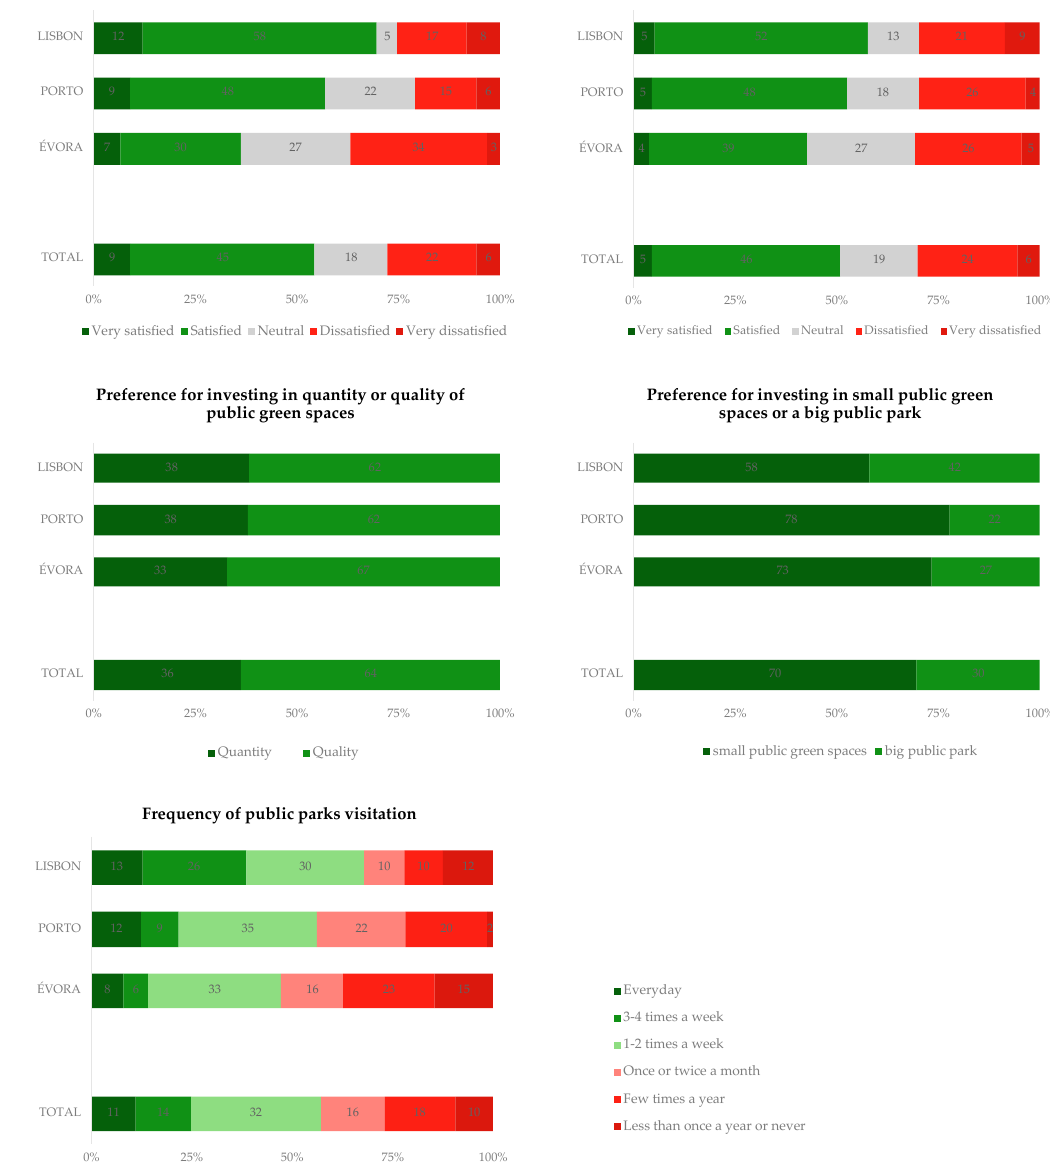
Figure 1. Global perceptions and aspirations for urban green spaces in Lisbon, Porto and Évora. The desire for future investments in public green spaces was assessed by two dichotomous questions. The first one focused on preferences for investing in the quantity or quality of their city’s public green spaces. In all three cities, respondents show a preference for investing in the quality of public green spaces (range by city, 62–67%), which seems to echo the criticisms that have been expressed in recent years against an emphasis on the provision of green space quantities and a reorientation of urban planning priorities towards urban green space quality [47–50]. The second question focused on preferences for investments in small public green spaces or in a large public park. More than two-thirds of the respondents show a preference for small public green spaces (70%, range by city, 58–78%). Similar preferences were found in studies conducted in the UK [51] and also in the Netherlands, suggesting that most people understand that a large urban park cannot satisfy all the needs of a varied and complex community [6].